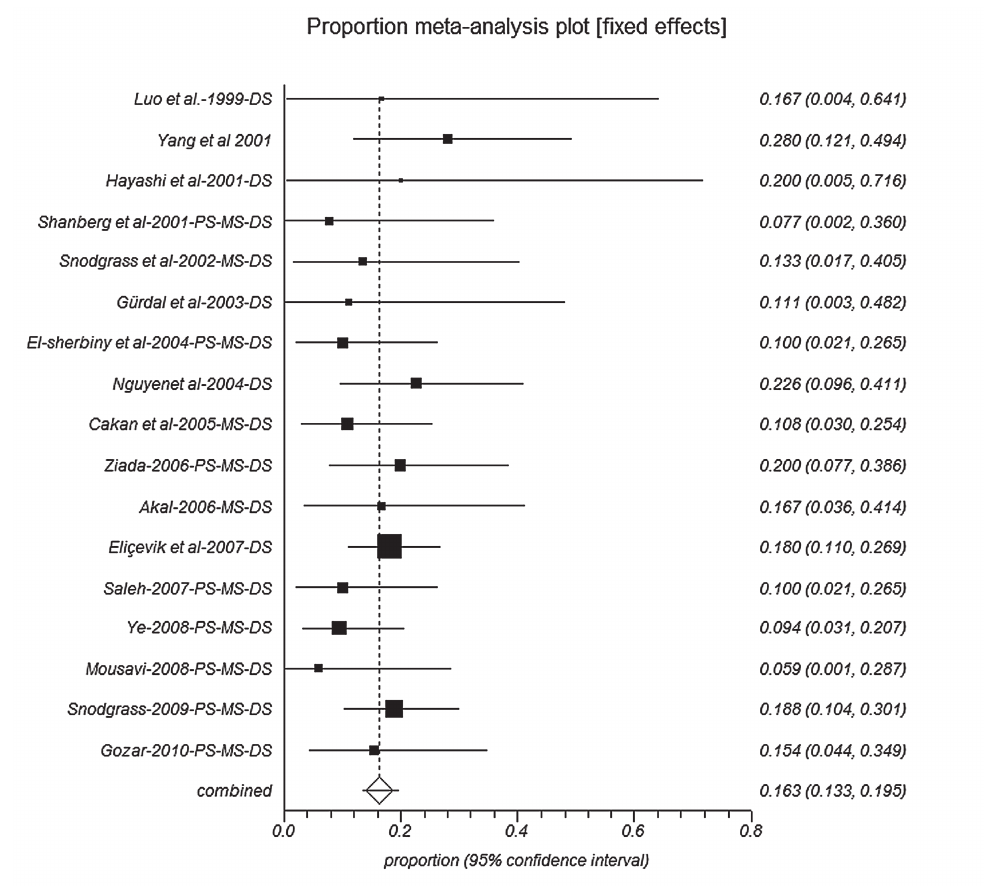
figure 1 - forest plot of overall complications of 18 secondary (redo) hypospadias operation studies (PS: Proximal shaft; MS: Mid shaft; DS: Distal